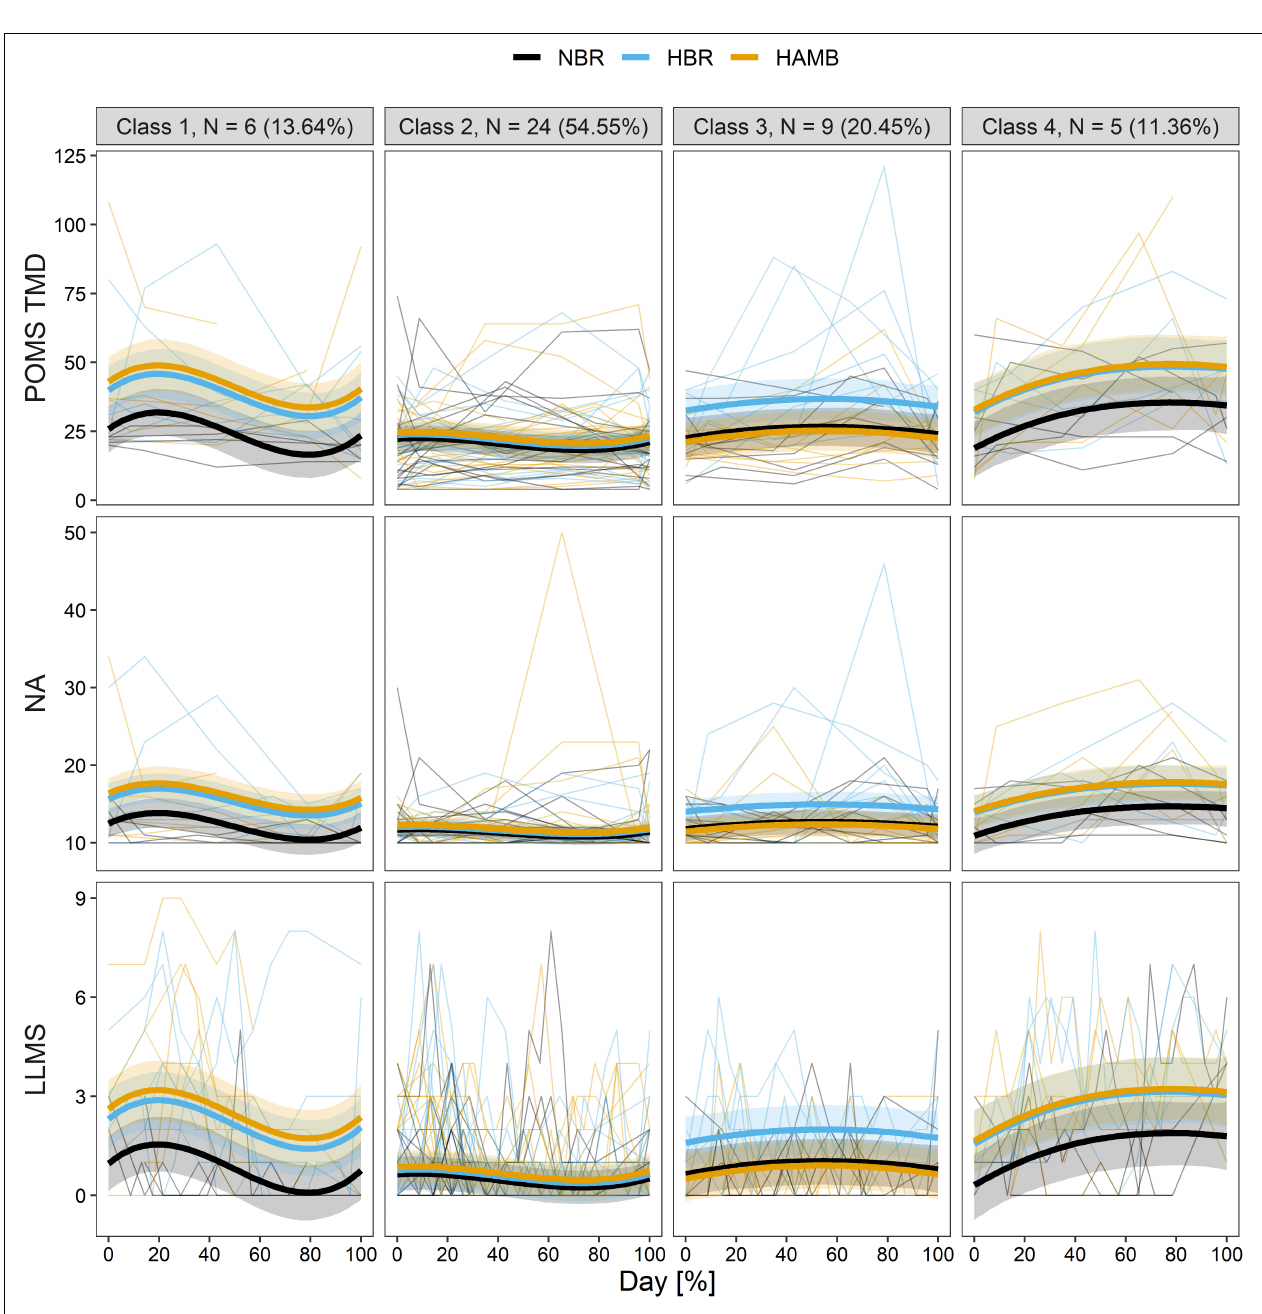
FIGURE 1 | The predicted trajectories of the four distinct classes in the longitudinal total mood disturbance of profile of mood states (POMS TMD; top row), negative affect (NA; middle row), and Lake Louis mountain sickness (LLMS; bottom row) during experiment of each of the interventions (HAMB, hypoxic ambulatory confinement; HBR, hypoxic bed rest; and NBR, normobaric normoxic bed rest). Bold lines show the class-specific mean predicted levels as a function of the percentage of duration, and the ribbons represent the corresponding 95% CI. Thin lines depict individual scores.